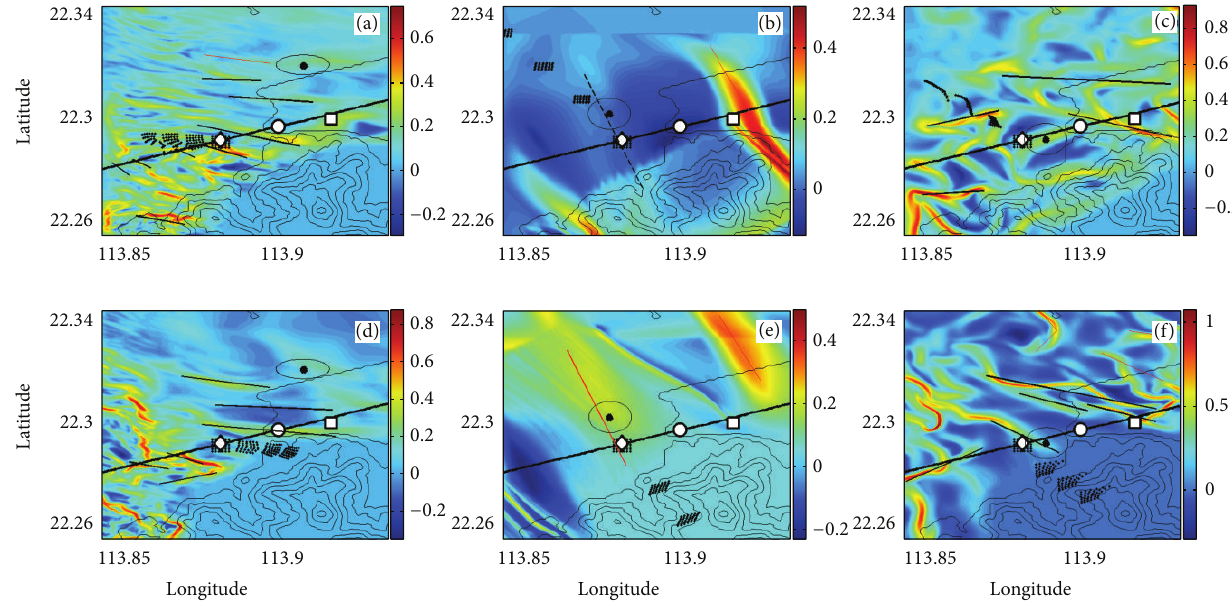
Figure 4: FTLE fields based on 2D emulated data on the LIDAR scanning cone. The panels are, from left to right, data from RAMS, FLOWSTAR, and WRF, respectively. The top panels are the forward time FTLE and the bottom panels are the backward time FTLE. The black straight lines and the black circles mark the same locations as seen in Figure 3 for reference.